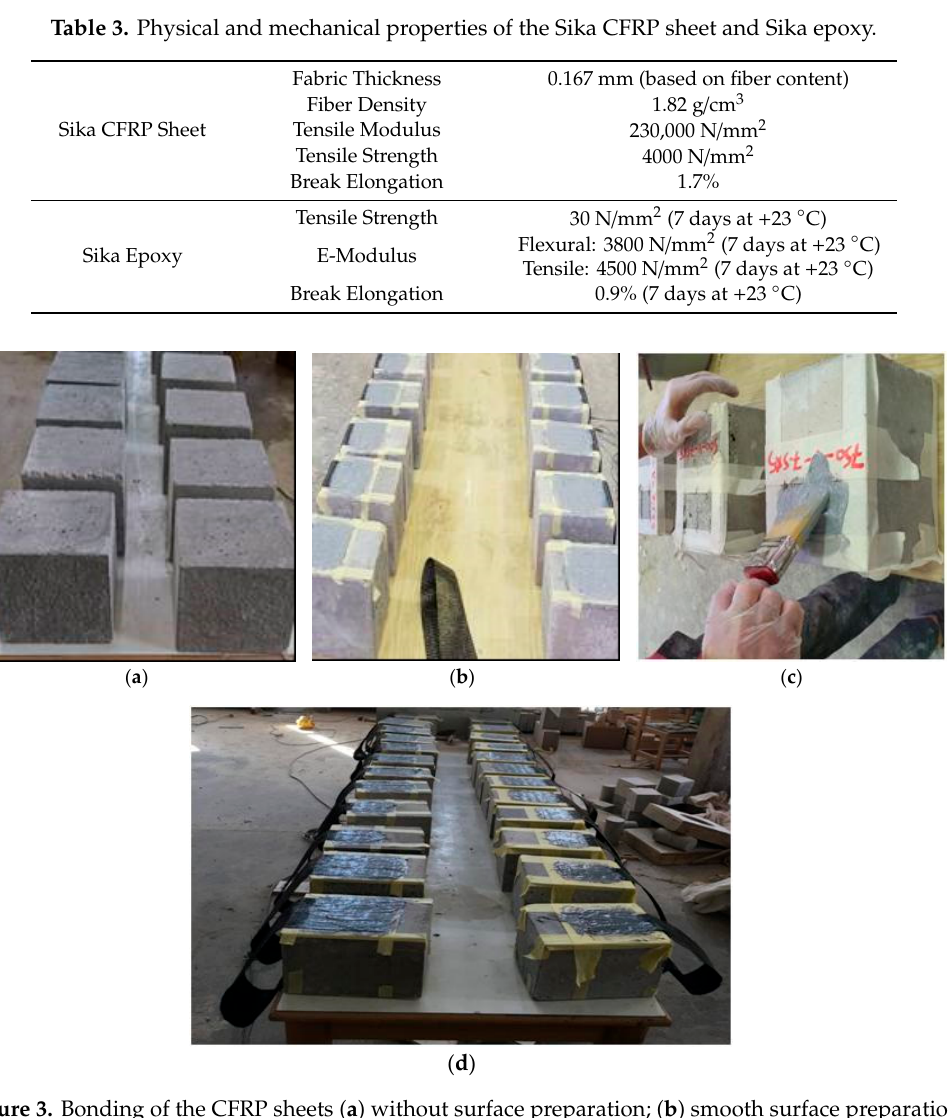
Figure 2. The time–temperature schedule.